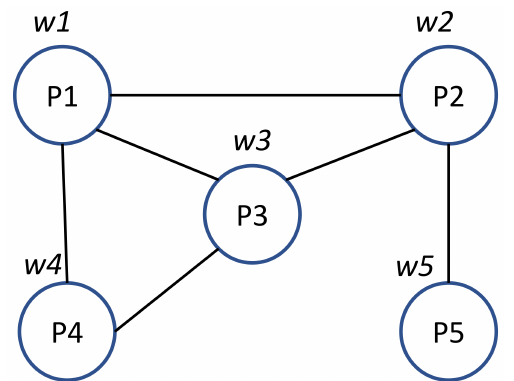
Figure 3. A simple population network graph. The vertices represent persons and the edges show interactions between them. The weights on vertices show the demographics of the